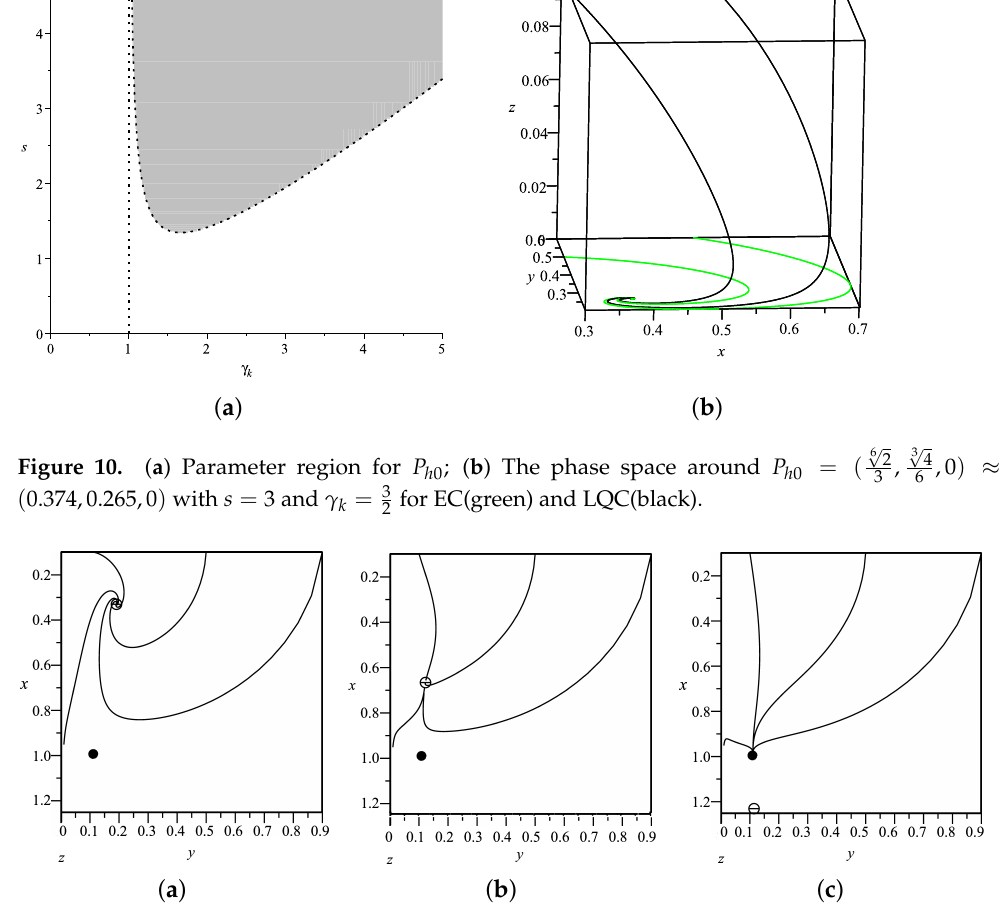
Figure 11. The stabilities corresponding to different values of coupling parameter α , which are shown by the projection from a 3-dim phase space onto to 2-dim x - y plane, and z -axis is vertical to the x - y plane. P g = ( 0.994,0.109,0 ) is displayed by a solid circle. ( a ) With α = 0, trajectories converge to stable point P h = ( 0.329,0.190,0 ) , just as [51] in EC; ( b ) With α = − 0.6 > − 0.985, trajectories still converge to stable point P h = ( 0.666,0.121,0 ) ; ( c ) With α = − 1.2 < − 0.985, all trajectories converge to P g which is a stable point in this case, but P h = ( 1.231,0.113,0 ) becomes